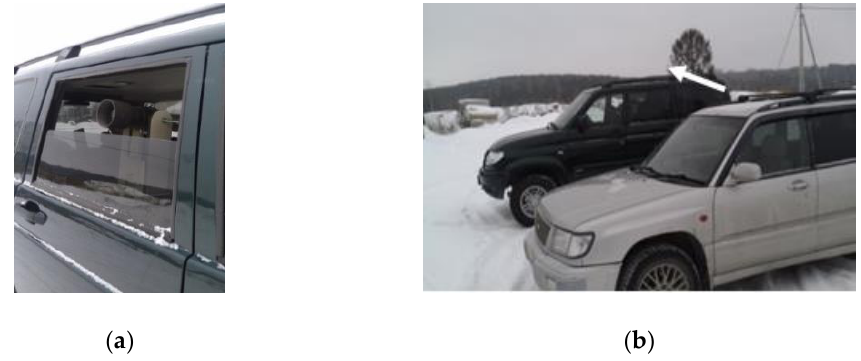
Figure 6. ( a ) Mobile optoelectronic communication systems (OECS); ( b ) direction (white arrow) of the optical axis of the receiving system.